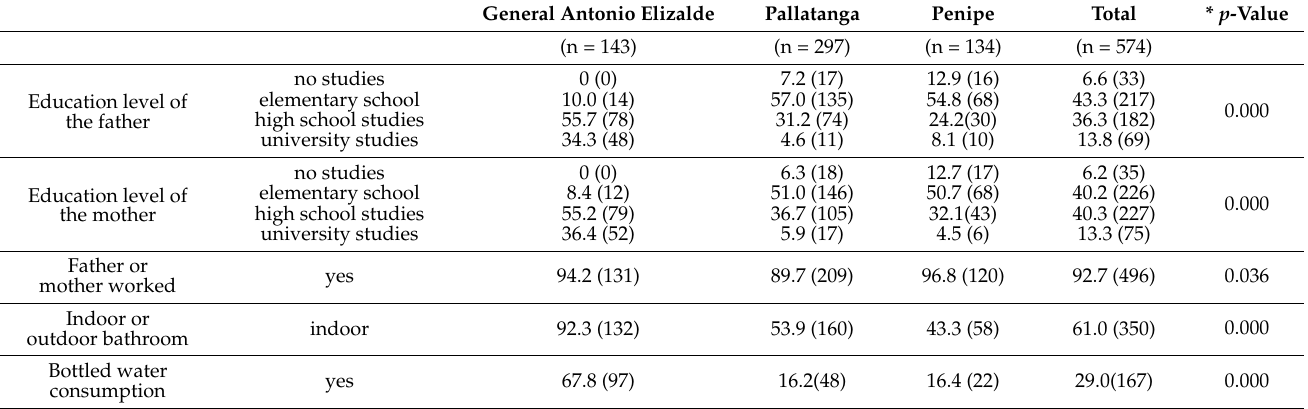
Figure 4. Participation rate (PR) and frequency (%) of the studied population according to gender and age group in the three municipalities. Data are shown as percentages of the total population stratified by municipality. The number of people is shown in brackets. There are no statistically significant differences ( p > 0.05) for the distribution of the frequencies of participants by age and gender between the three municipalities. Table 2 shows the following sociodemographic variables stratified by municipality: Table 2. Frequencies (%) of the studied population according to education level of the father, educa- tion level of the mother, whether father or mother worked, indoor or outdoor bathroom and bottled water consumption stratified by